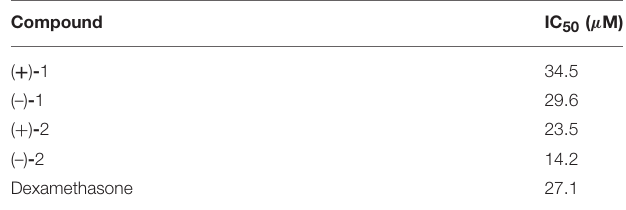
TABLE 2 | Inhibition of LPS-Induced NO